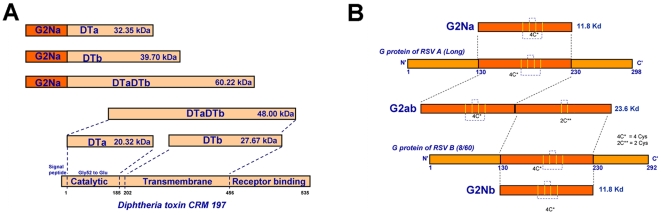
Schematic presentation of recombinant G protein derivatives.The gene encoding G2Na was fused to (A) DT derivatives resulting in G2NaDTa, G2NaDTb and G2NaDTaDTb. DTa was subcloned the nucleotide sequence encoding (aa1–185) of the catalytic domain of DT as described in Materials and Methods. Note that Gly res. at aa52 was substituted by Glu in order to inactivate DT toxicity. DTb was subcloned from the nucleotide sequence encoding (aa202–456) of the transmembrane domain of DT. DTaDTb is a fusion product of DTa to DTb. (B) G2b (aa130–230) of RSV-B G protein (8/60 strain) resulting in G2ab: in this fusion form, G2Na has 4 conserved Cys but G2b has only 2 conserved Cys176 and 182, the 2 outer Cys173 and Cys186 were substituted by Ser res. in order to avoid spurious disulphide bridges. G2Nb used for admixing with G2Na has all four Cys res.